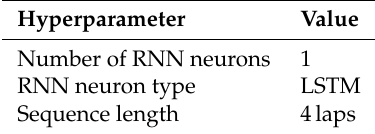
Table 11. Hyperparameters of the neural network for the pit stop decision (RNN section). Hyperparameter